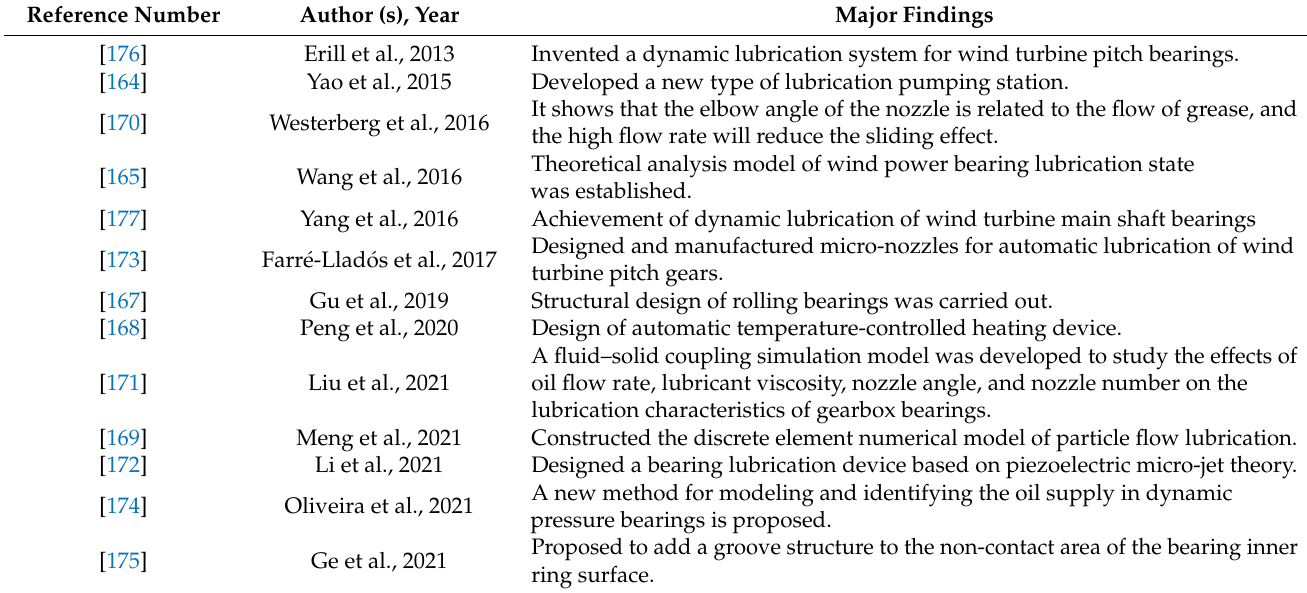
Table 7. Summary of research on wind turbine bearing lubrication